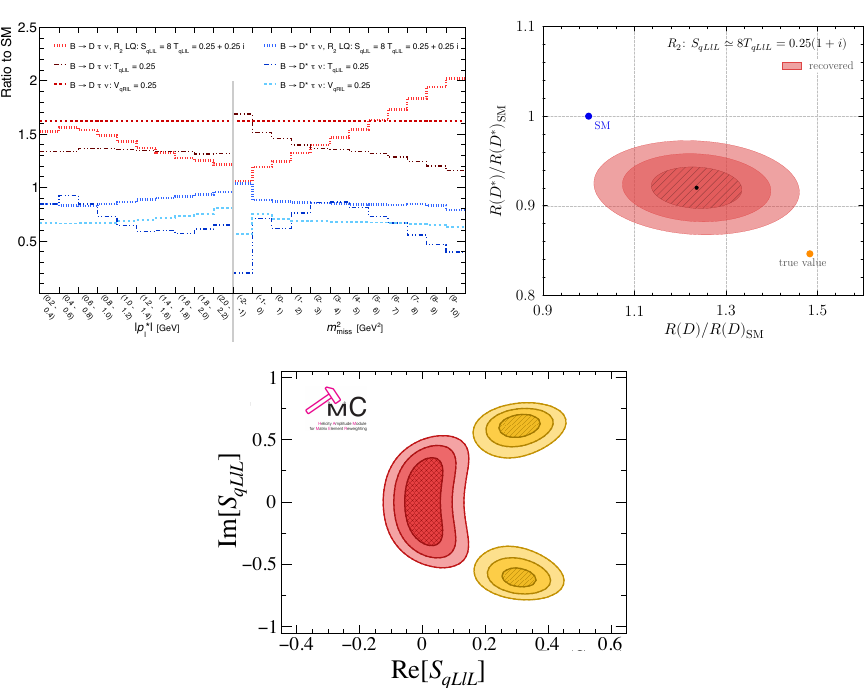
Figure 11: (Top left) The ratio of SM to new physics branching fractions for p (cid:96) and M 2 are shown for scalar, vector, and tensor contributions. (Top right) The bias miss of simplified reinterpretations of the measured ratios R ( D day measurements assume the SM nature of the underlying processes. (Bottom) The unbiased extraction of Wilson coefficients is demonstrated. This is a showcase for what can be achieved if full likelihoods and additional information would be published. All plots taken from Ref. [ 56 ]